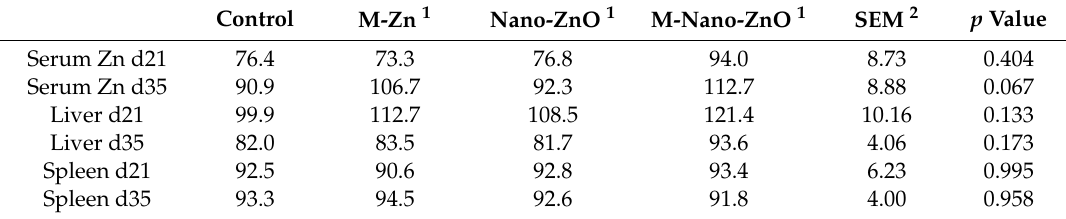
Table 5. E ff ect of zinc type on zinc content of blood serum ( µ g / dL), liver and spleen (mg / Kg) of